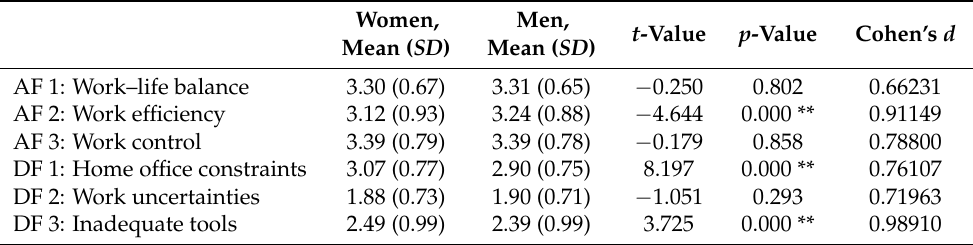
Women, Men, t -Value Mean ( SD ) Mean ( SD )